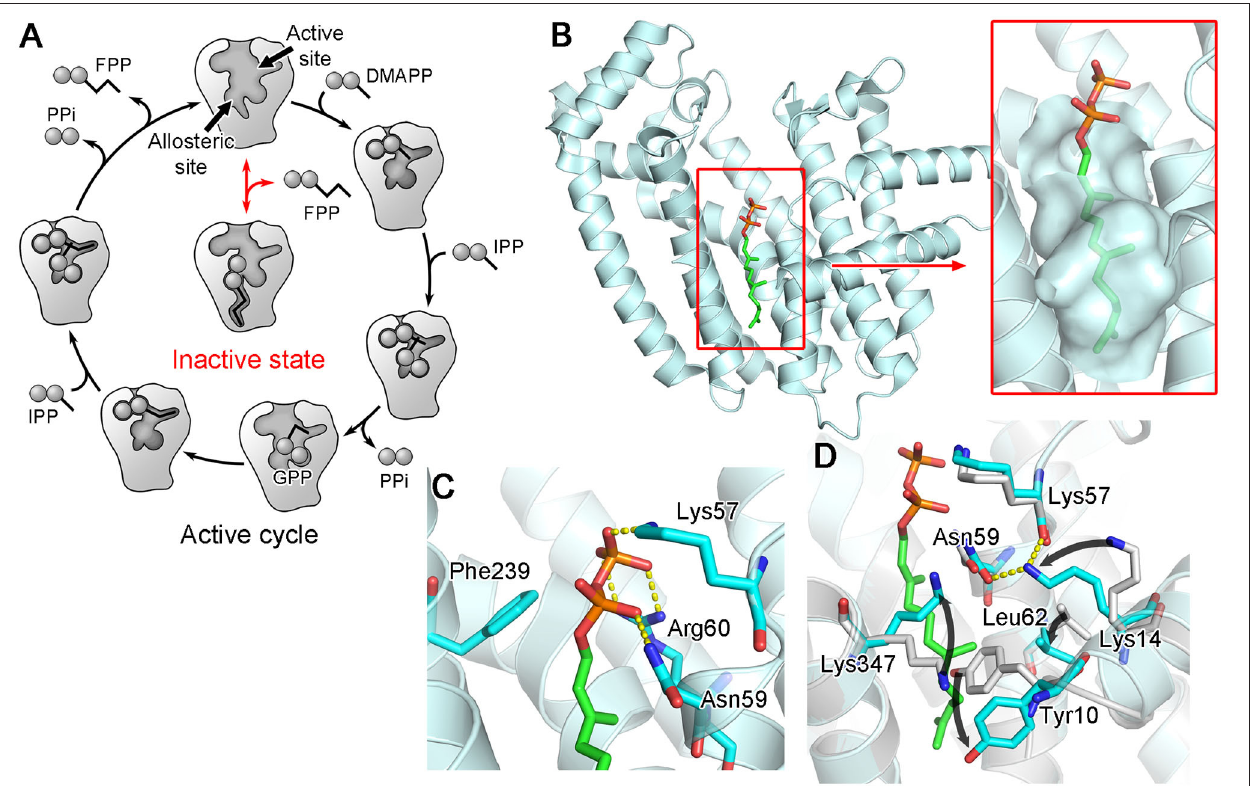
FIGURE 8 | Allosteric binding of FPP to hFPPS. (A) A schematic representation of FPPS catalytic cycle and allosteric product inhibition. FPP binding locks the enzyme in its open, inactive state. (B) A crystal structure showing FPP bound to the allosteric pocket (PDB ID: 5JA0). (C) Residues making direct interactions with the pyrophosphate moiety. (D) Conformational changes induced by FPP binding. Superimposed in gray is the structure of hFPPS in the unliganded state (PDB ID: